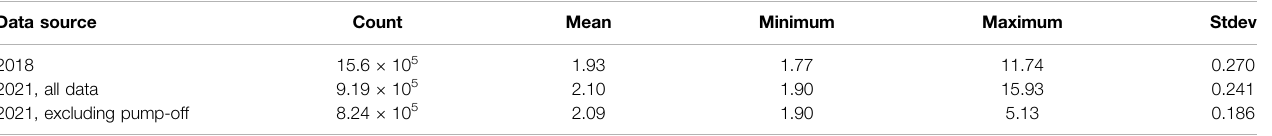
TABLE 4 | Summary statistics for atmospheric methane concentrations (ppmv) recorded from the cavity ring-down spectrometer in September 2018 and during the 2021 cruise of